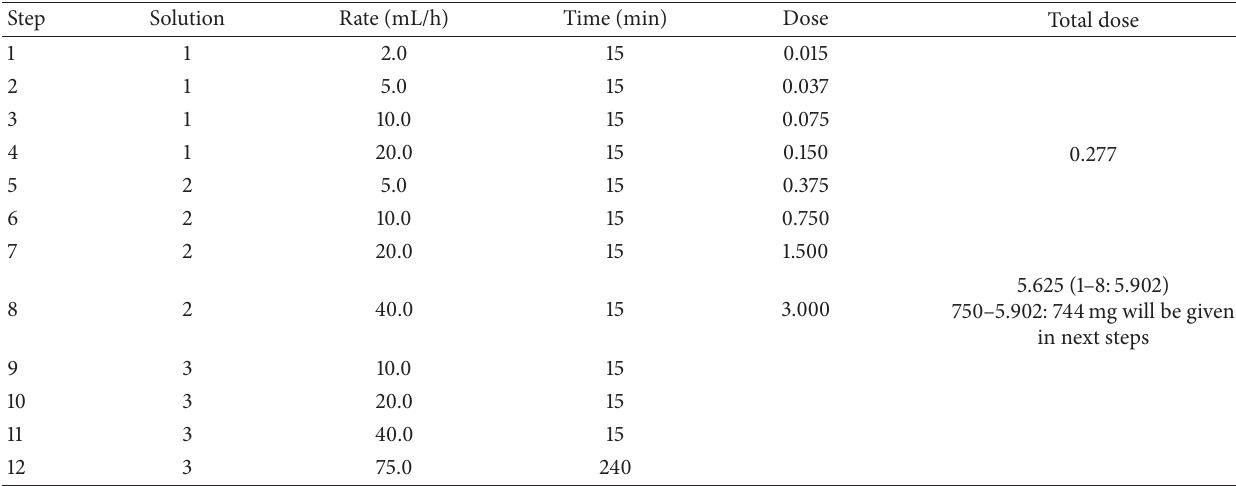
Table 1: Rituximab desensitization